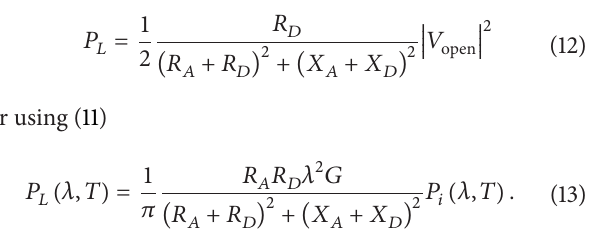
is the antenna impedance, where 𝑋 𝐴 is the antenna reactance and 𝑅 𝐴 is the antenna resistance which is a combination of the radiation resistance, modelling the radiated power, in series with the loss resistance and modelling the conductive and dielectric losses. Moreover, the capacitance, 𝐶 by the air gap should be considered in order to rightly model two-arm